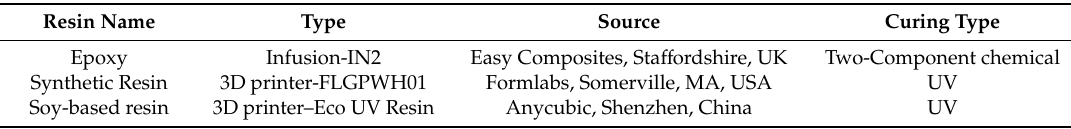
Table 2. Details of resins used in composite